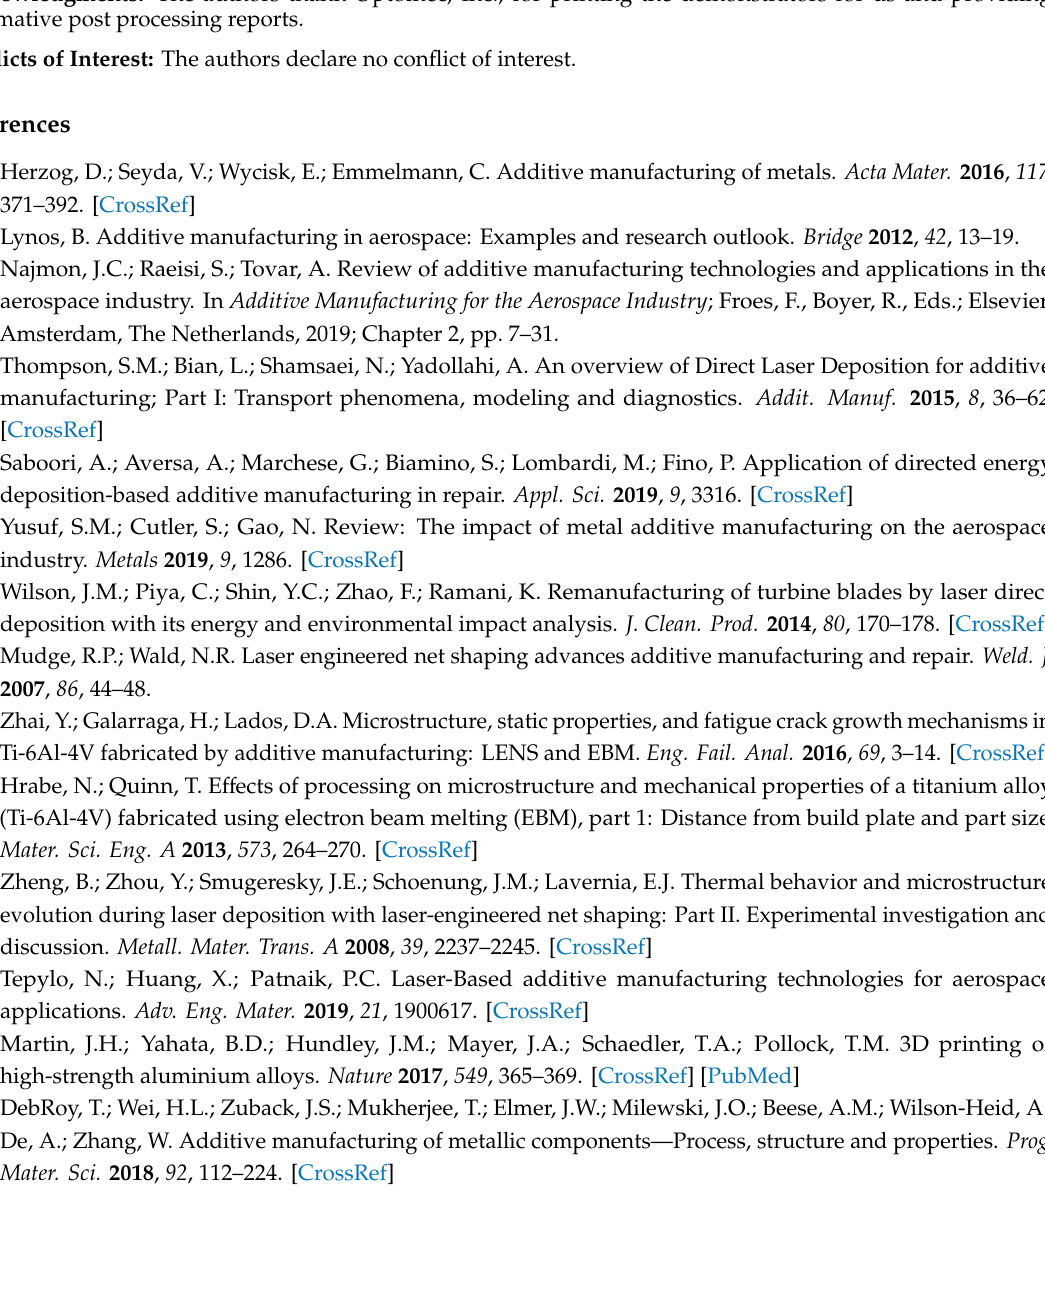
Figure S1: Calibration curve constructed by drawing the nominal values on the labels of the standard calibration specimens (Ra,real) versus the measured values (Ra,meas), Table S1: Measured surface roughness values ( µ m) for the 17–4 PH stainless steel rod, Table S2: Measured surface roughness values ( µ m) for the Ti–6Al–4V fitting, Table S3: Measured surface roughness values ( µ m) for the Al 4047 housing, Table S4: Measured roughness values ( µ m) for three standard calibration specimens with di ff erent label nominal